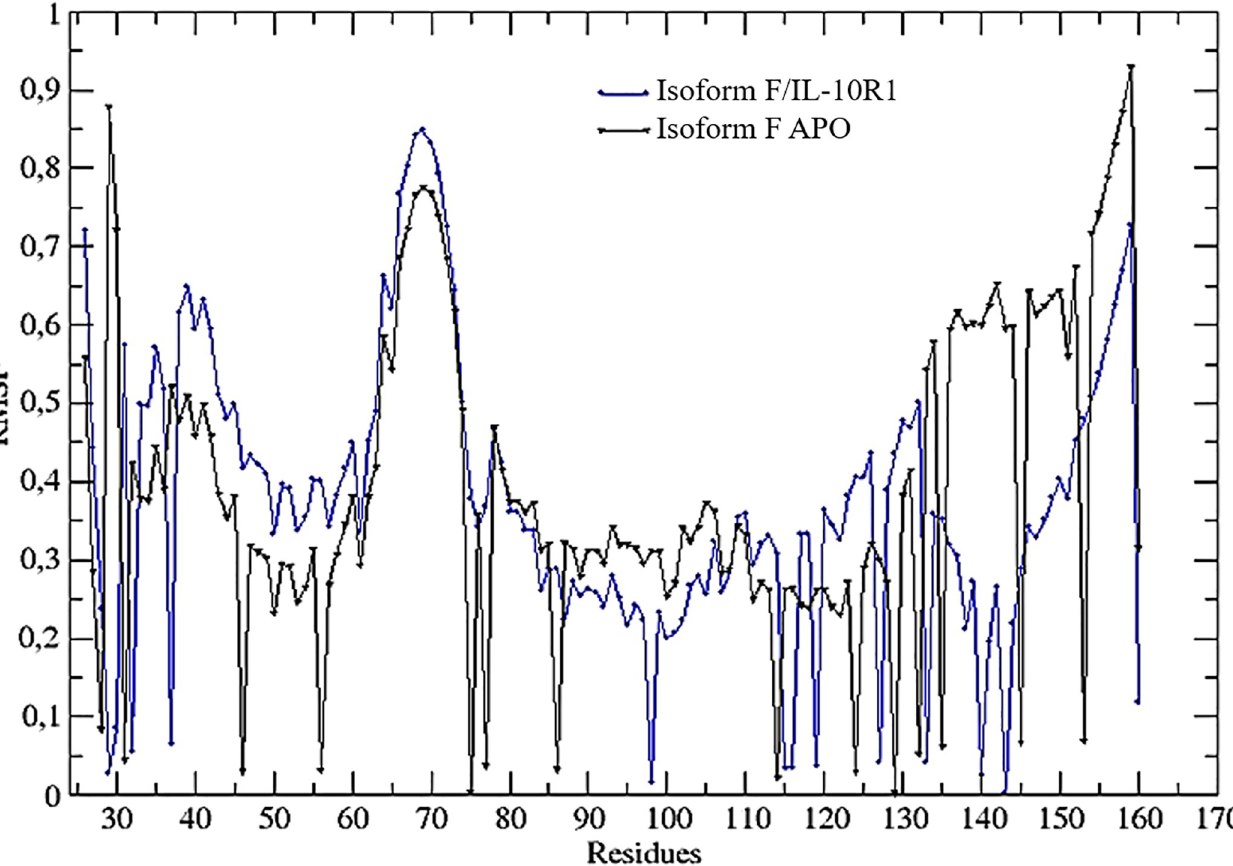
Fig 4. Difference in root mean square fluctuation (RMSF) Presented values between isoform F complexed with the IL-10R1 and isoform F in Apo conformation, in green and blue respectively.